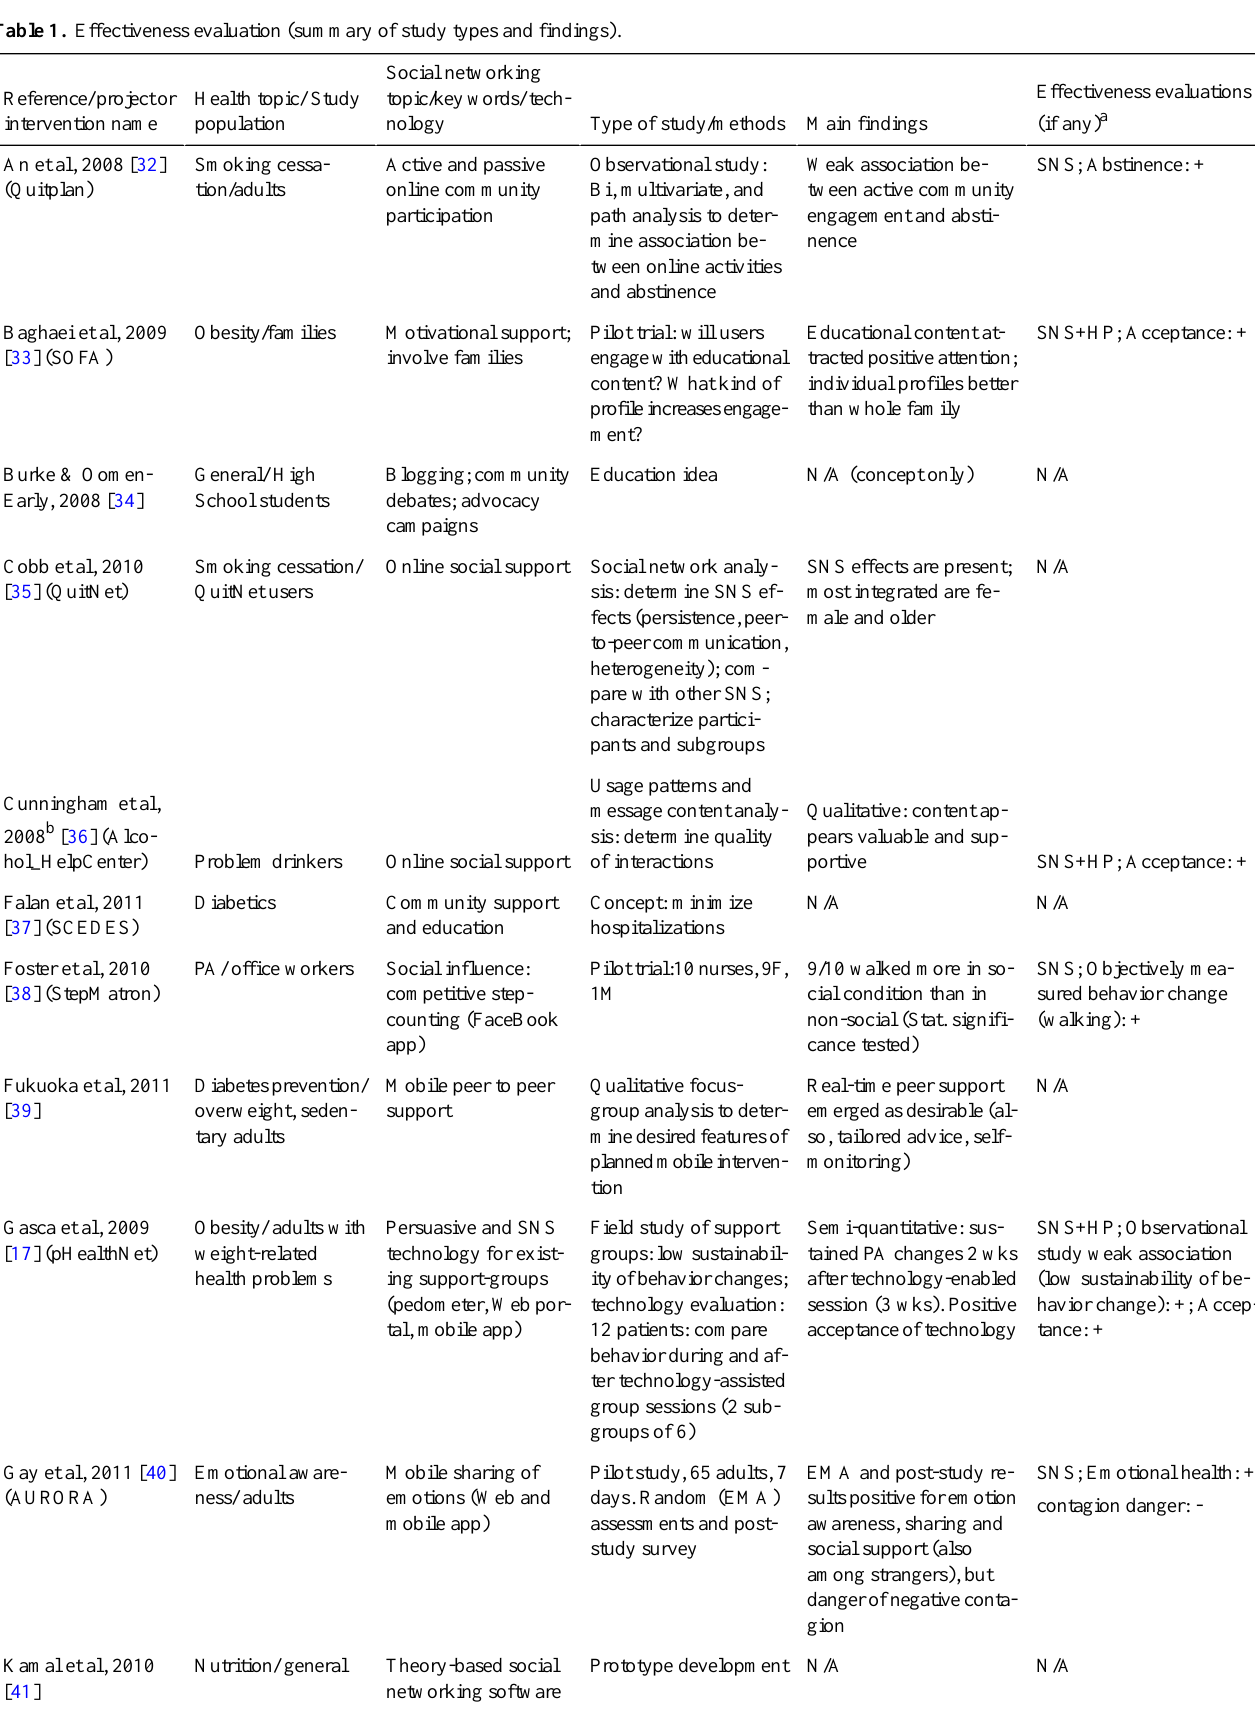
Table 1. Effectiveness evaluation (summary of study types and